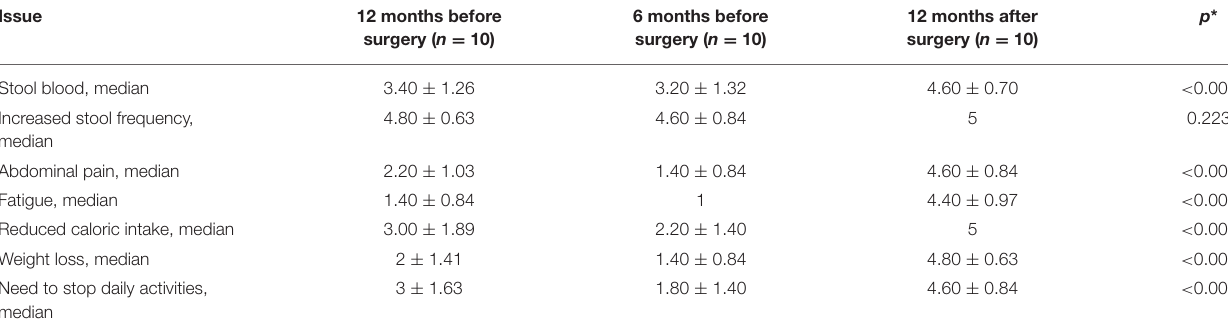
TABLE 2 | Systemic and IBD symptoms score preoperatively and 6 and 12 months after surgery. Issue 12 months before surgery ( n = 10)